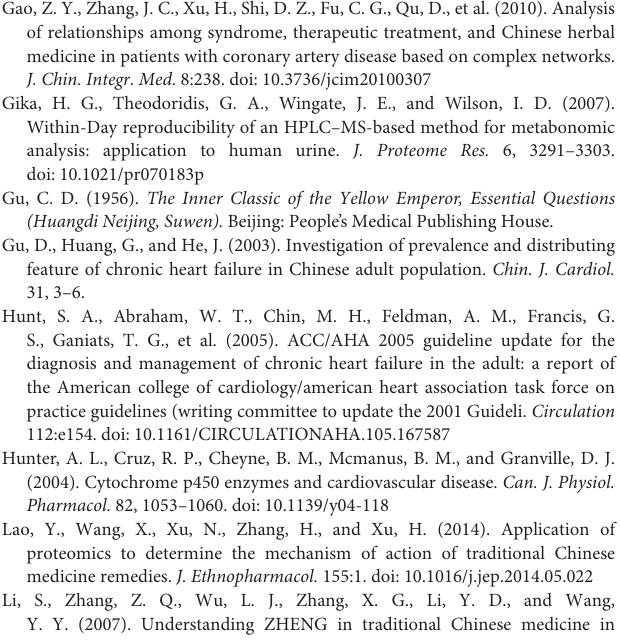
Supplementary Figure 1 | Representative based peak intensity (BPI) chromatograms of samples with NH, QD, QB and QBW. NH, Normal healthy group; QD, Qi deficiency group; QB, Qi deficiency and Blood stasis group; QBW, Qi deficiency and Blood stasis and Water retention group. Supplementary Figure 2 | Representative based peak intensity (BPI) chromatograms of samples with NH, Prior & Post-CHM group and Prior & Post-Placebo group NH, Normal healthy group; CHM, Chinese herbal medicine group. Supplementary Figure 3 | PCA result among QD, QB, QBW and NH. 4NH, Normal healthy group; 1QD, Qi deficiency group; 2QB, Qi deficiency and Blood stasis group; 3QBW, Qi deficiency and Blood stasis and Water retention group. Supplementary Table 1 | Baseline Characteristics of Validation Phase Participants. Supplementary Table 2 | Proteins and KEGG Pathways